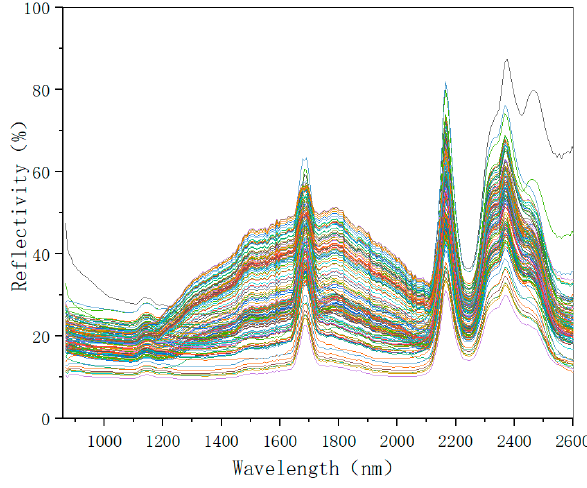
Figure 5. Original spectrogram of soil sample.